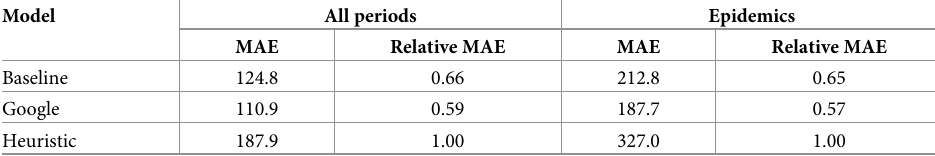
Table 3. Comparison of error in chikungunya case count estimates for the heuristic model, baseline nowcasting model and nowcasting model using Google searches. We compare the mean absolute errors (MAEs) for the chikun- gunya nowcasts produced by the heuristic model, baseline model and model using Google searches. The first two col- umns show results across the sample as a whole, reported in number of cases and relative improvement in comparison to the heuristic model. The baseline nowcasting model is far more accurate than the heuristic model, reducing MAE by 34%. The model using Google searches improves further upon the baseline, reducing MAE by 41% relative to the heu- ristic model. The third and fourth column show results when only considering epidemic periods. Here we see that the error reductions offered by both the baseline model and model using Google searches increase further: the baseline model reduces MAE relative to the heuristic model by 35%, and the model using Google searches reduces MAE by 43%.